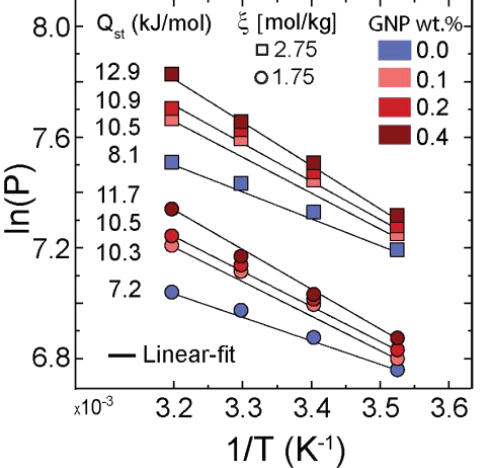
Figure 6. A linear plot of ln(P) versus 1/T at two excess molar concentrations ( ξ ) of